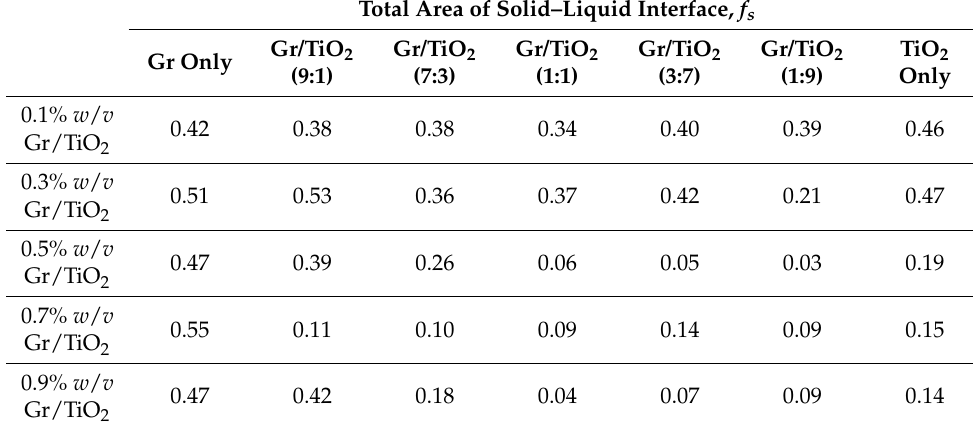
Table 1. The total area of the solid–liquid interface of the graphene/TiO 2 -coated PLA film with the concentration of 0.1% to 0.9% and different graphene to TiO 2 ratios. Gr and TiO 2 represent the abbreviation of graphene and titanium dioxide, respectively. Total Area of Solid–Liquid Interface, f s Gr/TiO 2 Gr/TiO 2 Gr/TiO 2 Gr/TiO 2 Gr/TiO 2 TiO 2 Gr Only (9:1) (7:3) (1:1) (3:7) (1:9)